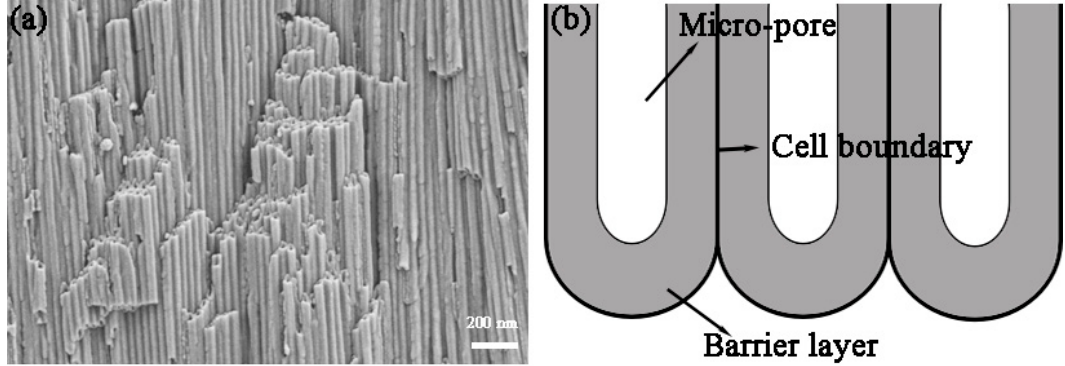
Figure 3. Cross-sectional SEM micrographs of the HA coating with cylindrical cells ( a ) and an illustration of barrier layer ( b ).